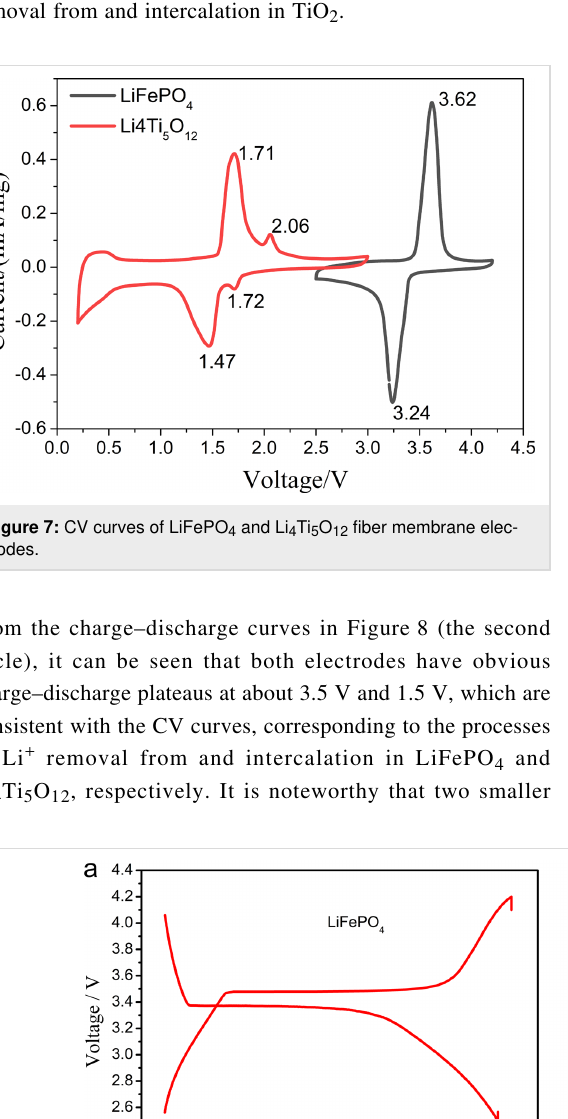
Electrode performance